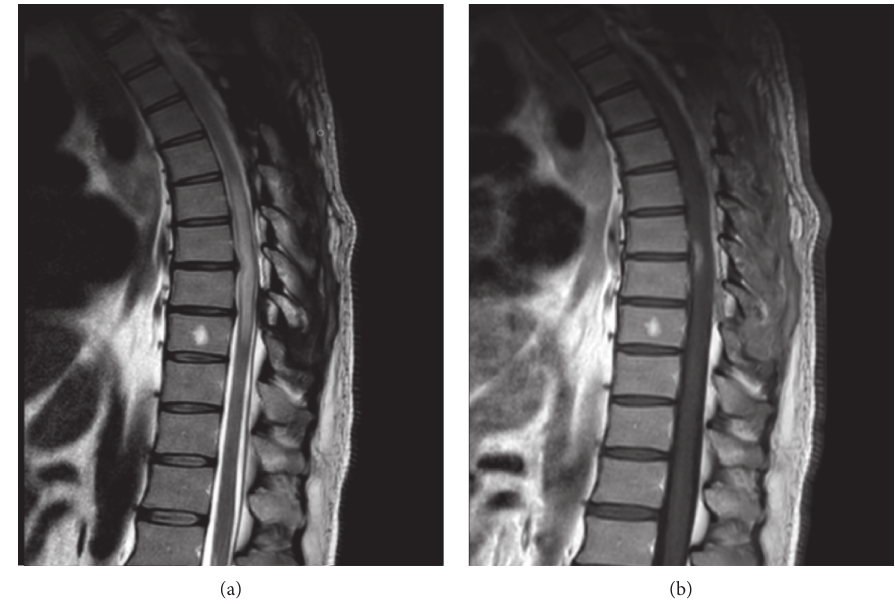
Figure 4: (a) Sagittal T2 MRI showing resolution of the epidural lipomatosis with resolution of the mass effect on the spinal cord and decrease in the extent of the lesion (from T6 to T9). (b) Sagittal T1 MRI with gadolinium showing mild decrease in the size of enhancing lesion.